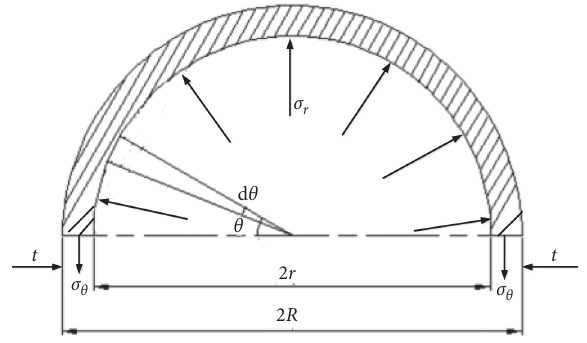
Figure 4: Half ring body force